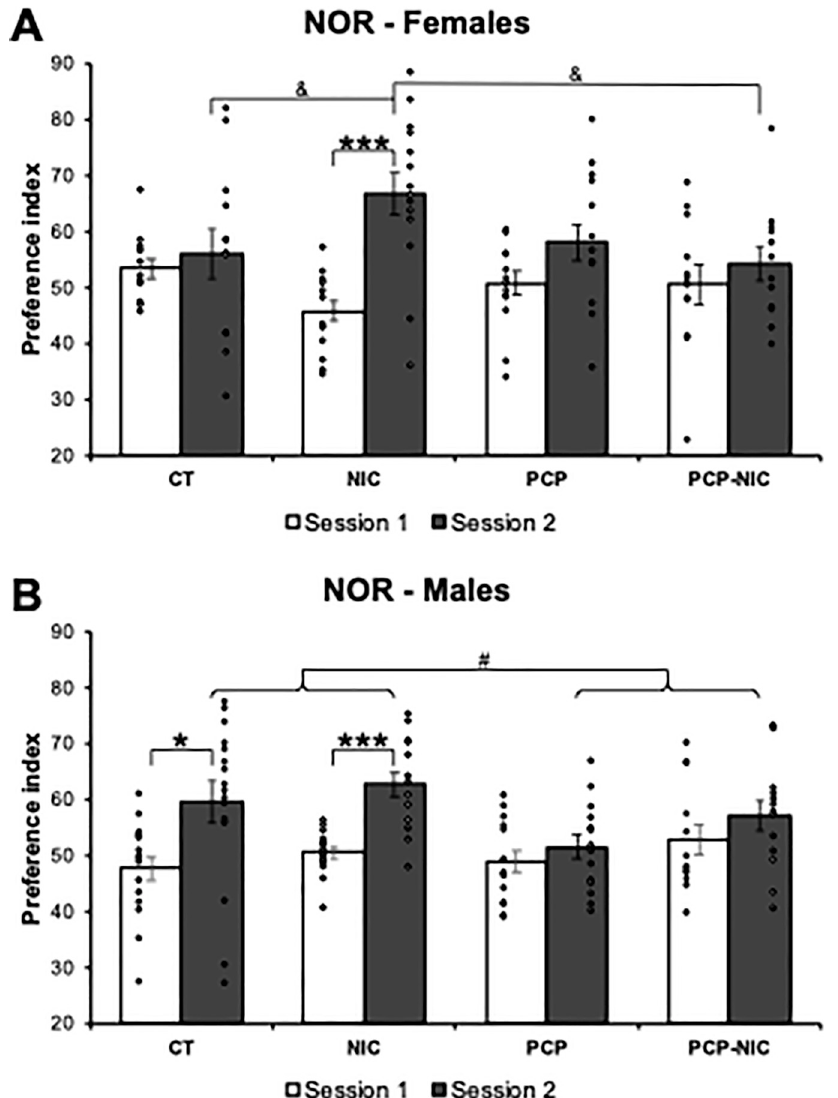
Fig 3. Effects of phencyclidine treatment, nicotine history and the combined insults on the preference index of adolescent (A) female and (B) male mice, as assessed in the novel object recognition test. CT: Control group ( ♀ = 12, ♂ = 16); NIC, Nicotine-exposed group ( ♀ = 14, ♂ = 14); PCP: Phencyclidine-treated group ( ♀ = 14, ♂ = 14); PCP-NIC: Phencyclidine-treated and nicotine-exposed group ( ♀ = 12, ♂ = 13). S1: Session 1; S2: Session 2. Values are means ± SEM. � p < 0.05, ��� p < 0.001, S1 vs . S2 within each experimental group. # p < 0.05, phencyclidine-treated (PCP and PCP-NIC) vs . phencyclidine non-treated (CT and NIC) mice in Session 2. & p < 0.05, NIC vs . CT and PCP-NIC mice in Session